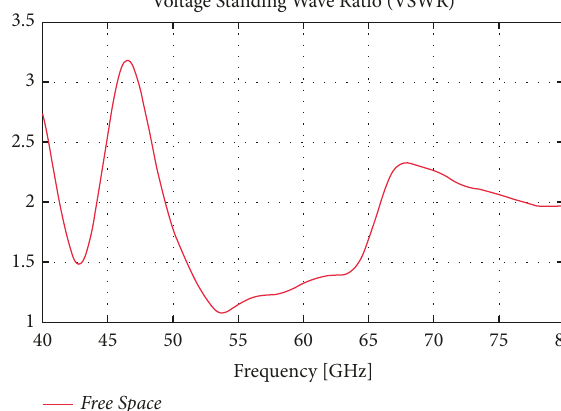
Figure 19: VSWR curve of the 1 × 2 antenna